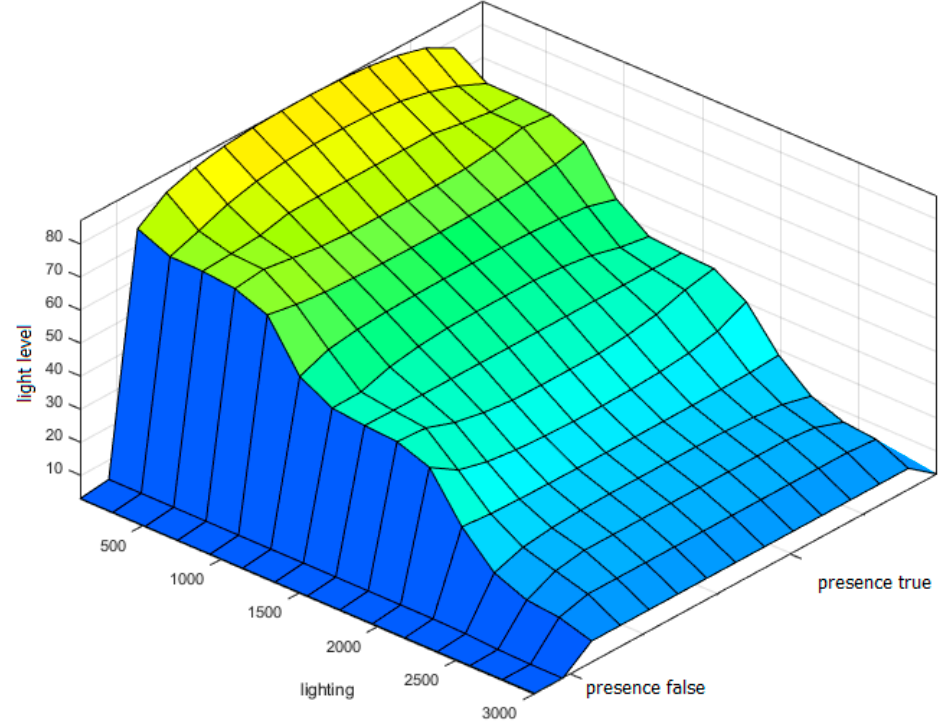
Figure 6. Lighting level dependency on presence and luminosity of light.